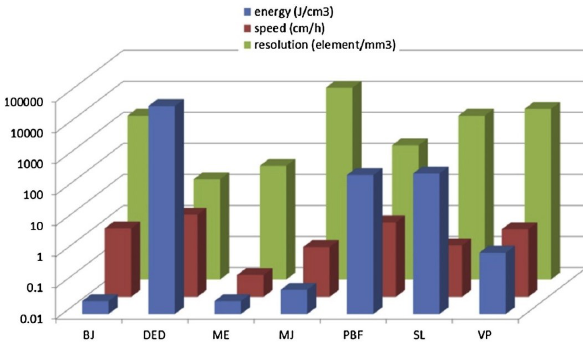
Figure 3: Relative energy use compared to the speed and